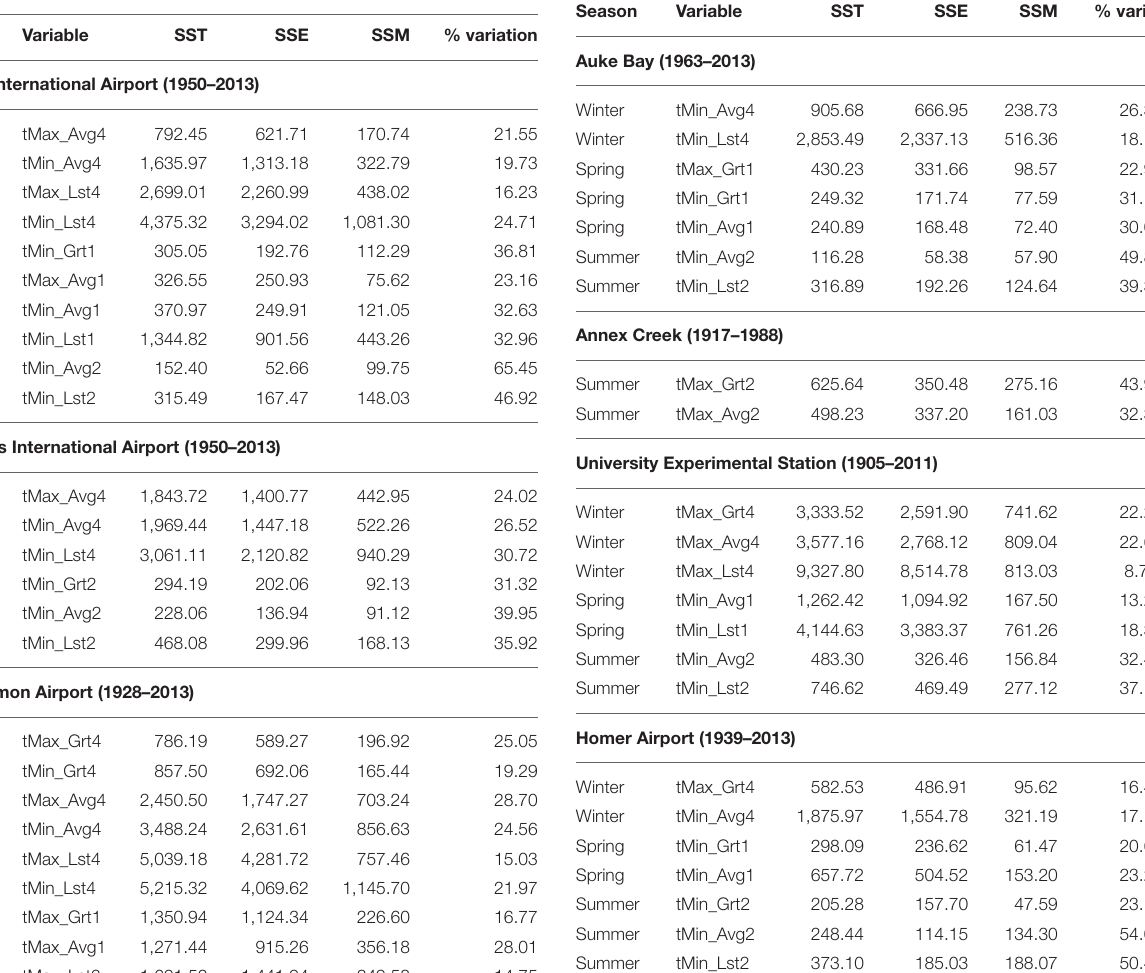
TABLE 5 | Values of total sum of squares (SST), sum of squares of squares due to error (SSE), sum of squares due to model (SSM), and %Variation = (SSM/SST) × 100 for all variables in all seasons with at least one significant change-point at stations JIA (representing southeastern region), FIA (representing interior region), and KSA (representing southwestern region).